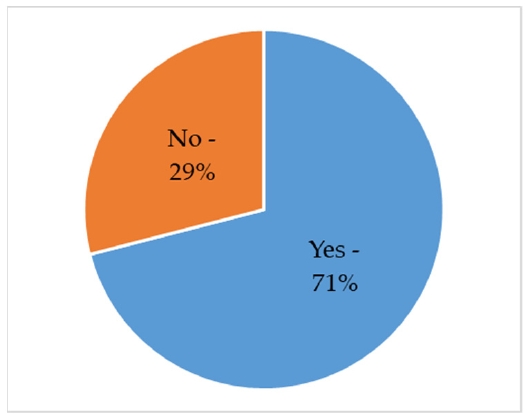
Figure 6. Selected survey results—an analytical–social perspective: how do you assess the level of acceptance by the residents of your province for the creation of RES installations (other than prosumer installations) near their place of residence?